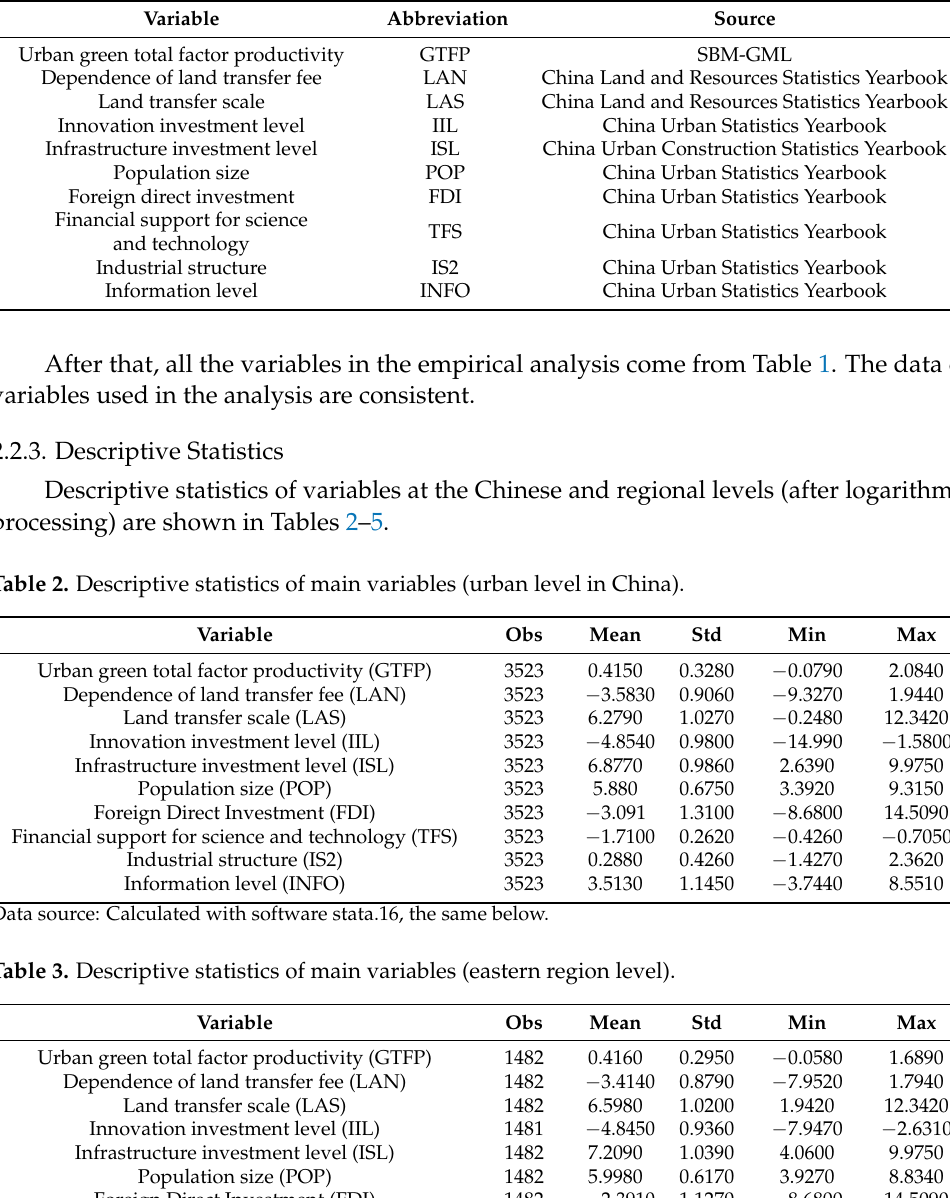
Table 1. Variable data source.